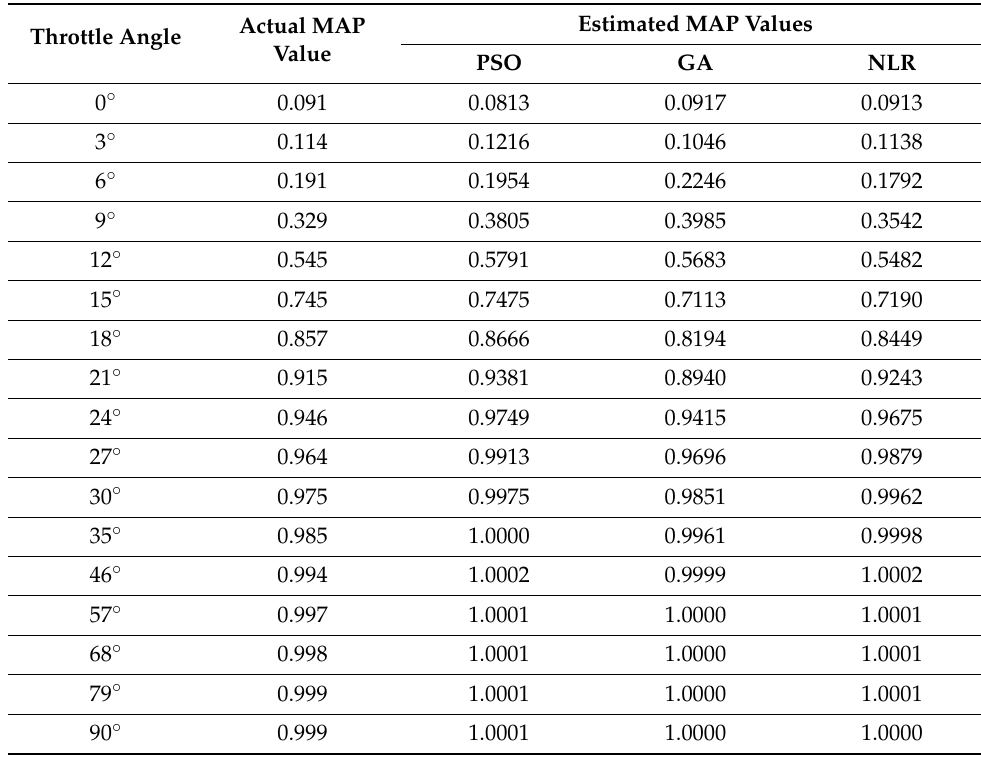
Table 4. Estimated MAP values with PSO, GA, and NLR.